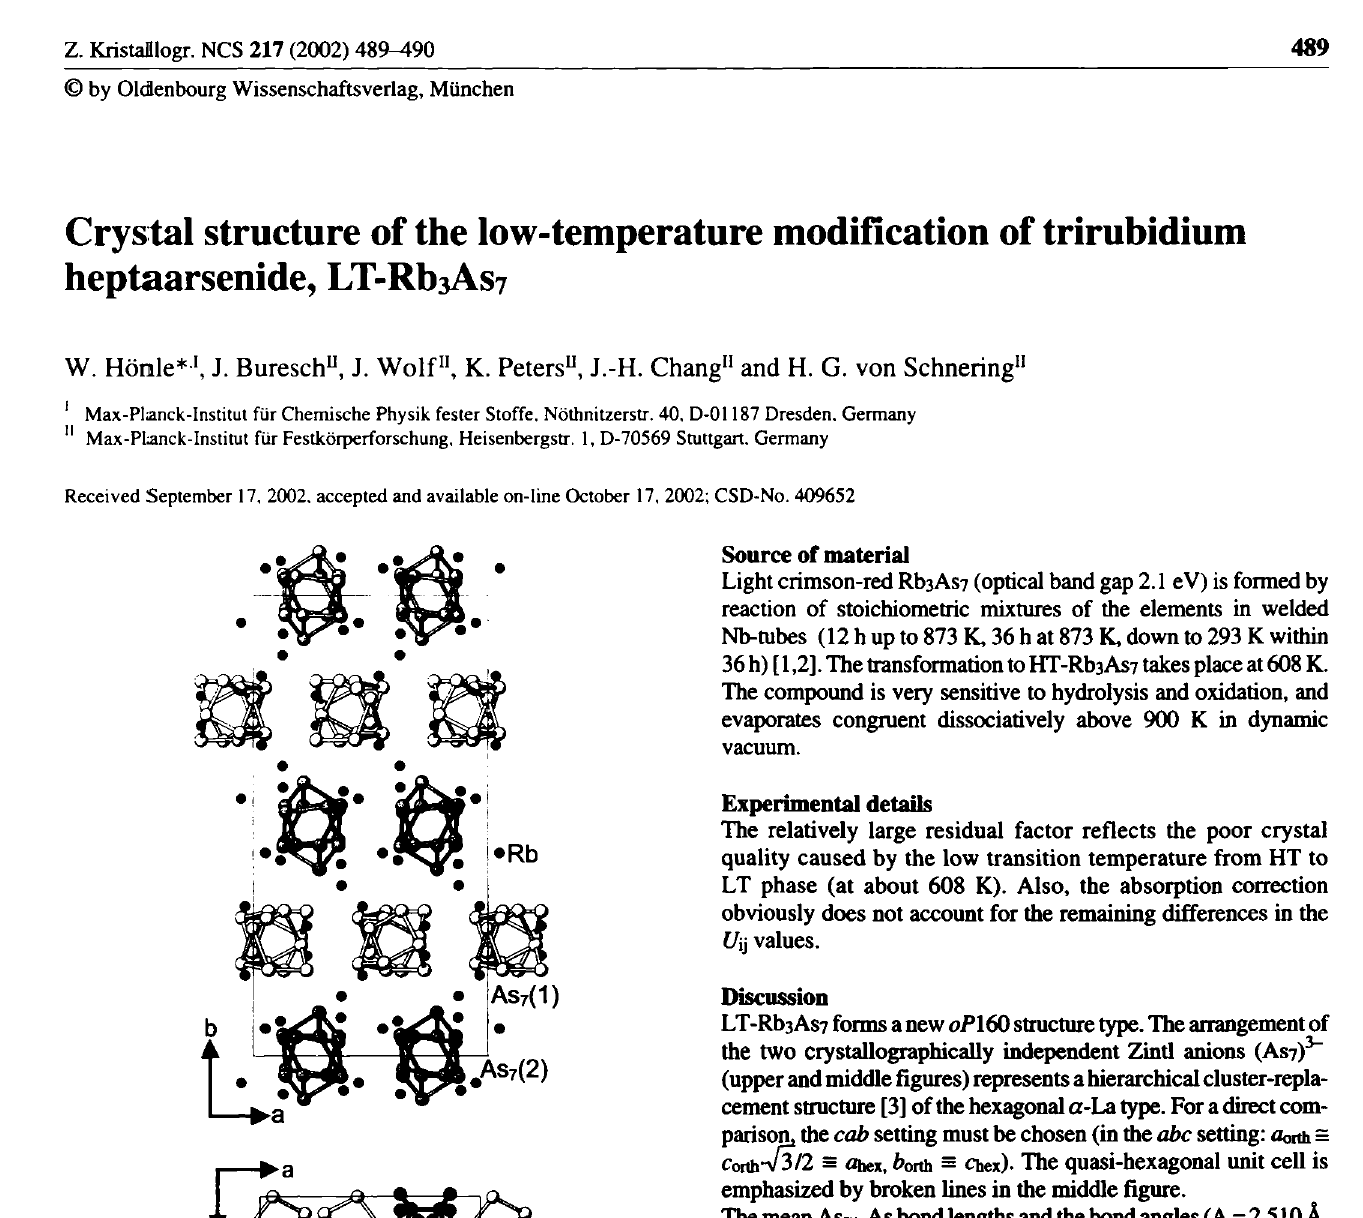
Table 1. Data collection and